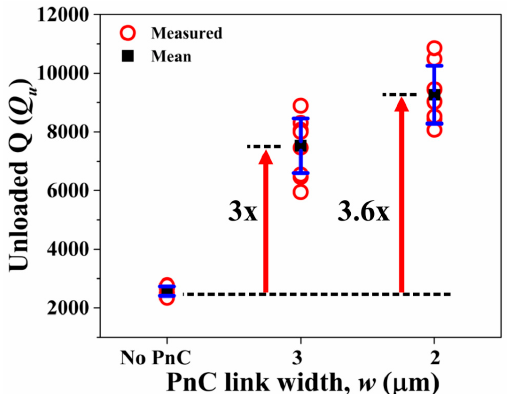
Figure 7. Partially covered resonators with three IDT fingers transduced in the 7th-order symmetric Lamb mode—Extracted values of unloaded Q ( Q u ) of the control design with no PnCs in comparison to the two other designs with PnCs in the anchors with different inter-cell link widths. The black squares denote the mean value while the error bars denote the standard deviation over six samples for each resonator design.